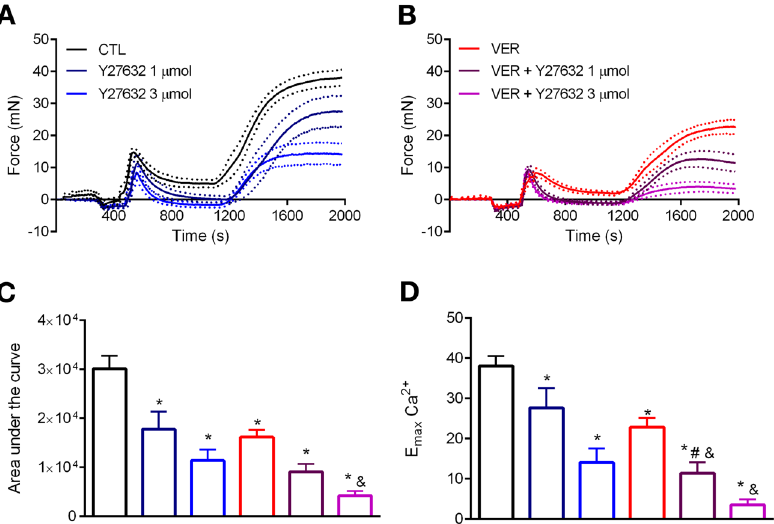
Figure 6. Blockade of HSP70 intensifies the inhibitory effect of a Rho-kinase inhibitor in aorta stimulated 2 + with phenylephrine. Aortic rings were challenged with phenylephrine ( 10 µ mol/l ) in 0[ Ca ] Krebs’ solution in the presence of vehicle (CTL) or ( A ) Y27632 (1 and 3 µ mol/l, DMSO diluted) or ( B ) VER155008 ( 10 µ mol/l , DMSO diluted) as well as the combination of Y27632 and VER155008. Inhibitors were added before IP3r- 2 + 2 + mediated Ca release. The concentration of Ca was restored after 10 min, and the force developed was evaluated for 15 min. ( C ) Area under the curve and ( D ) E max . Panels ( C , D ) use the same color scheme as panels ( A , B ). Data are expressed as mean ± SEM. n = 9 for CTL and VER and n = 6 for all other groups, * p < 0.05 vs. CTL, # p < 0.05 vs. Y27632, and& p < 0.05 vs. VER.